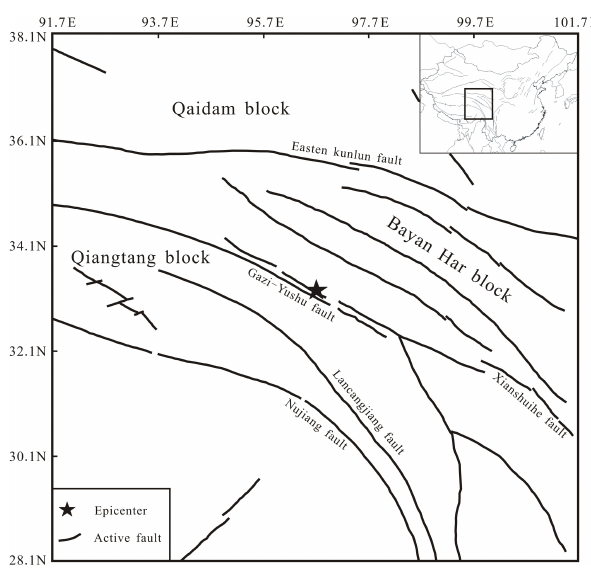
Fig. 1. The epicentre of the Yushu M s = 7 . 1 earthquake on 14 April 2010 and main active faults in analysis area (source: China Active Faults.tab, MapSIS Software v. 2011, CEA, 2011). The eastern Ti- betan Plateau is divided into several blocks. Eastern Kunlun fault is the boundary of Qaidam block and Bayan Har block. Xianshuihe fault is the boundary of Bayan Har block and Qiangtang block. Great earthquakes mainly occurred at these block boundaries. Seis- mic activity is relative weak inside blocks (Deng et al.,